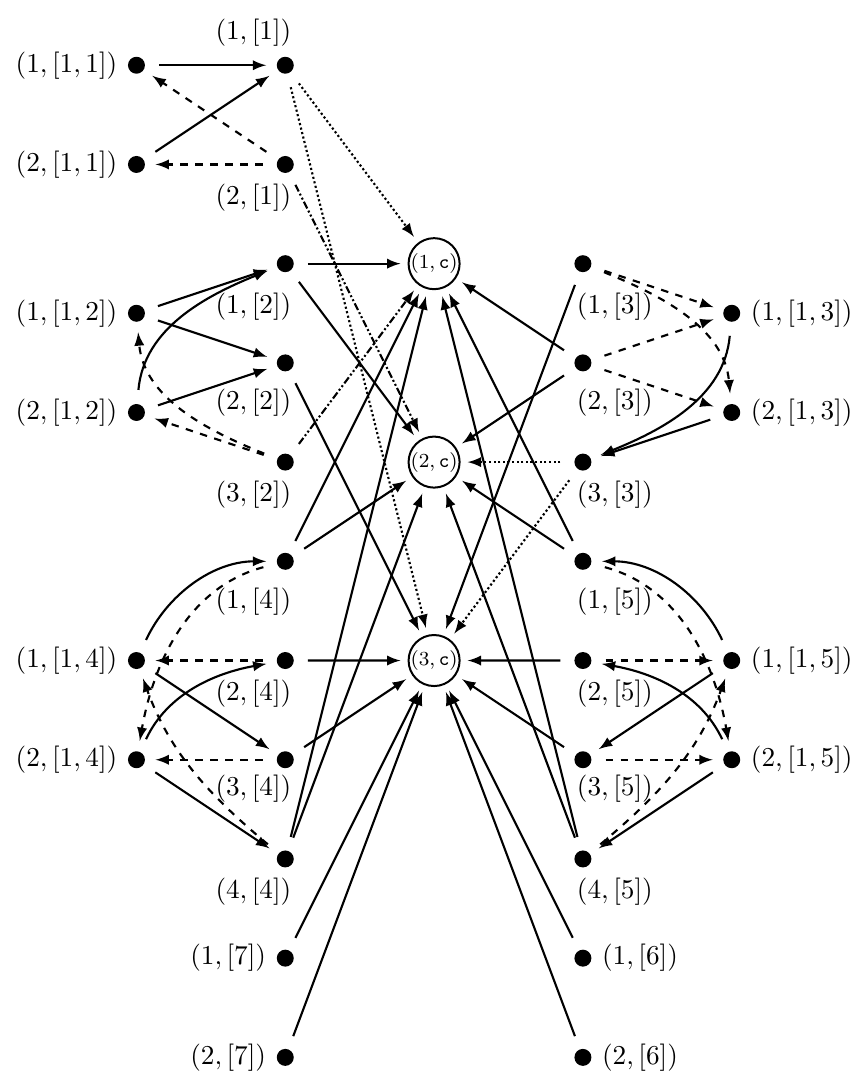
Figure 10: Orientation D for H for s = 3, A = { [1] } , A = { [2] , [3] } , A 2 3